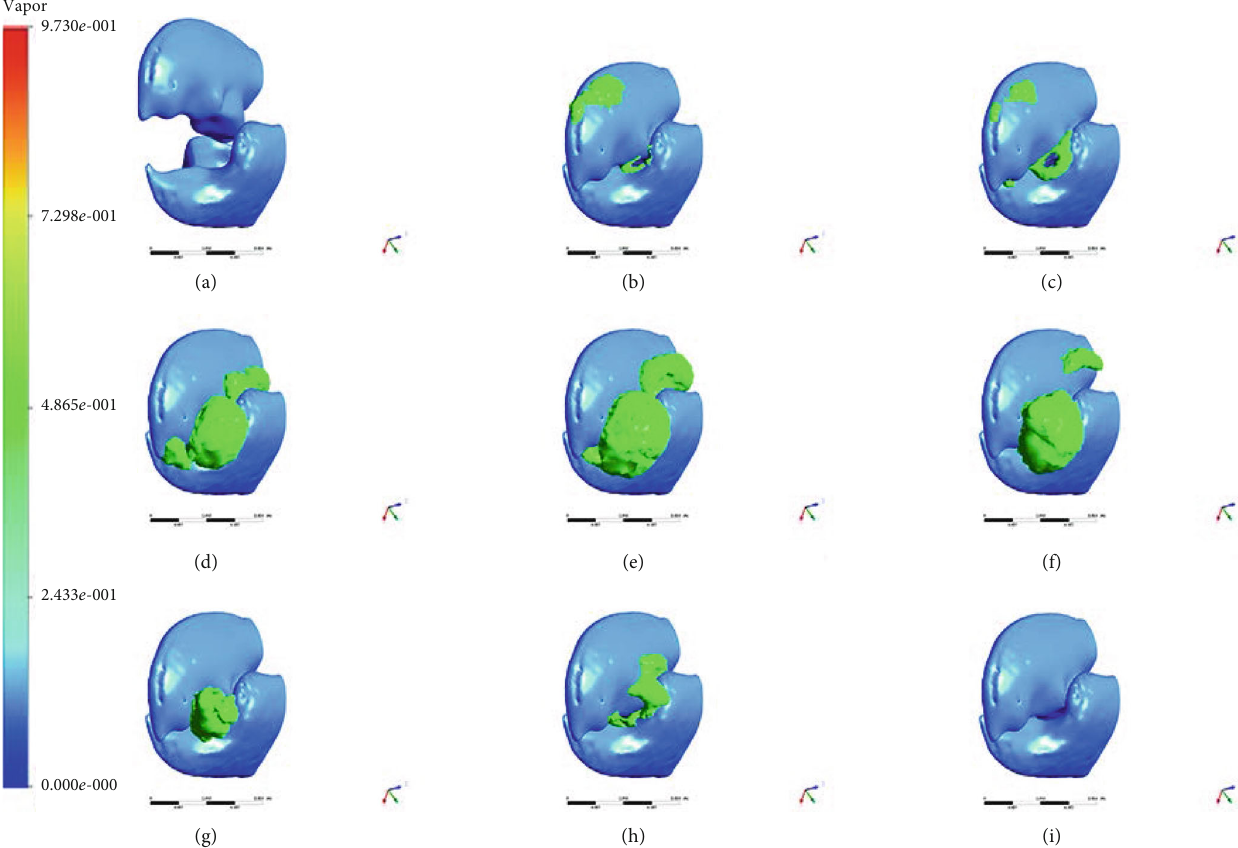
Figure 3: Indicative instances of the snapper claw model closure. The green part represents the cavitation bubble with the vapor volume of